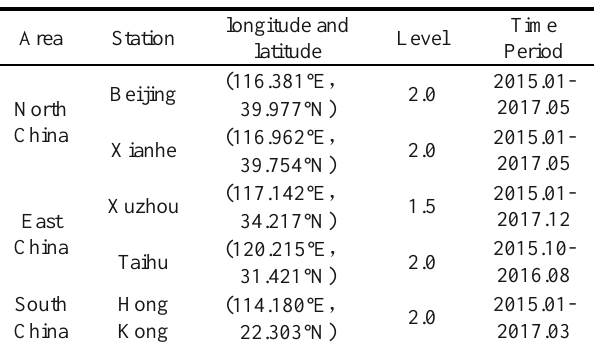
Table 1. Observation time and level of AERONET AODs in the